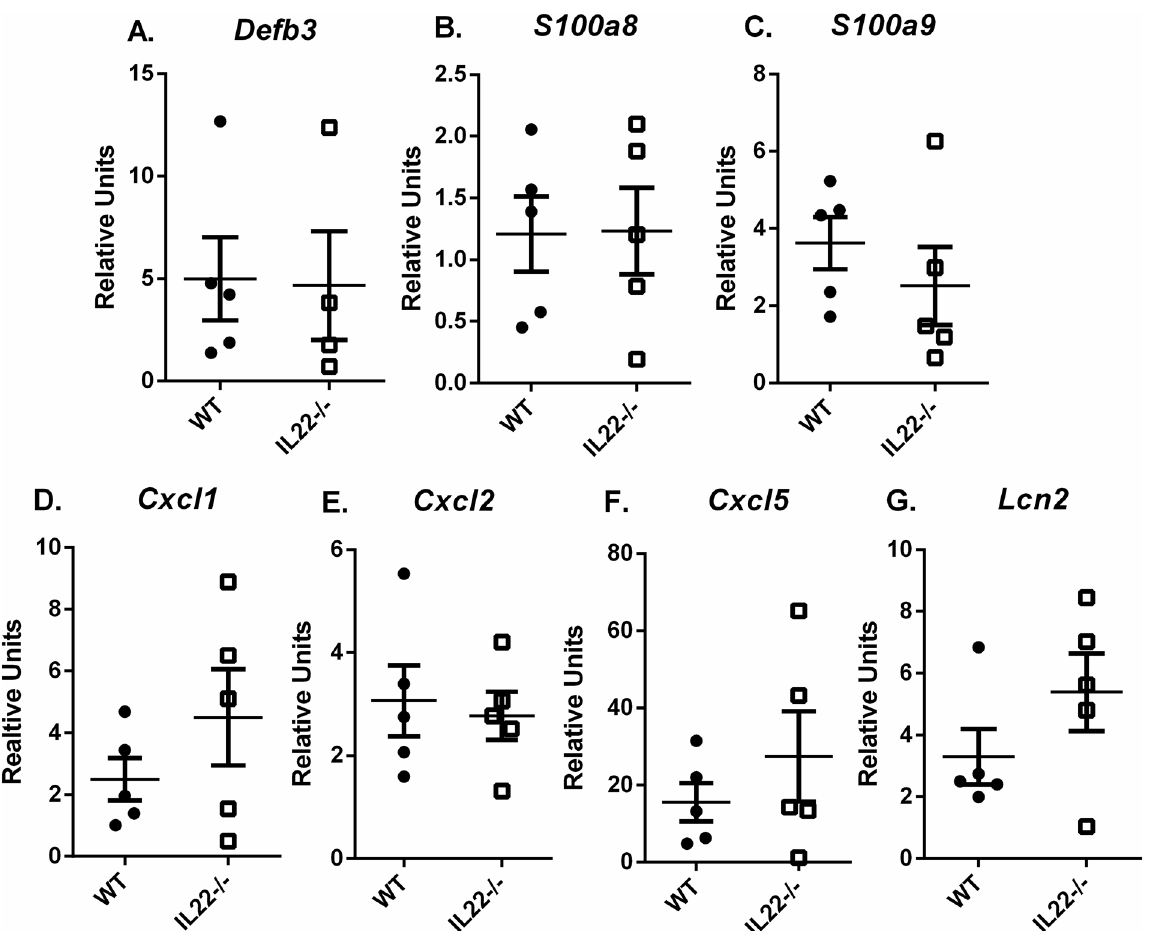
Fig 5. IL-22 deficiency had minimal effect on gene expression in the mouse during H . pylori infection. At 1 months post infection, no significant difference in expression of Defb3 (p = 0.524), Lcn2 (p = 0.31), S100a8 (p = 0.944), S100a9 (p = 0.31), Cxcl1 (p = 0.413), Cxcl2 (p = 0.944) and Cxcl5 (p = 0.532) as measured between H . pylori – infected WT and infected IL-22-/- mice gastric tissue. Relative units are calculated as described in the methods, relative to GAPDH and calibrated to uninfected WT mice. Statistical analysis was performed using Mann-Whitney U (Error bars represent ±